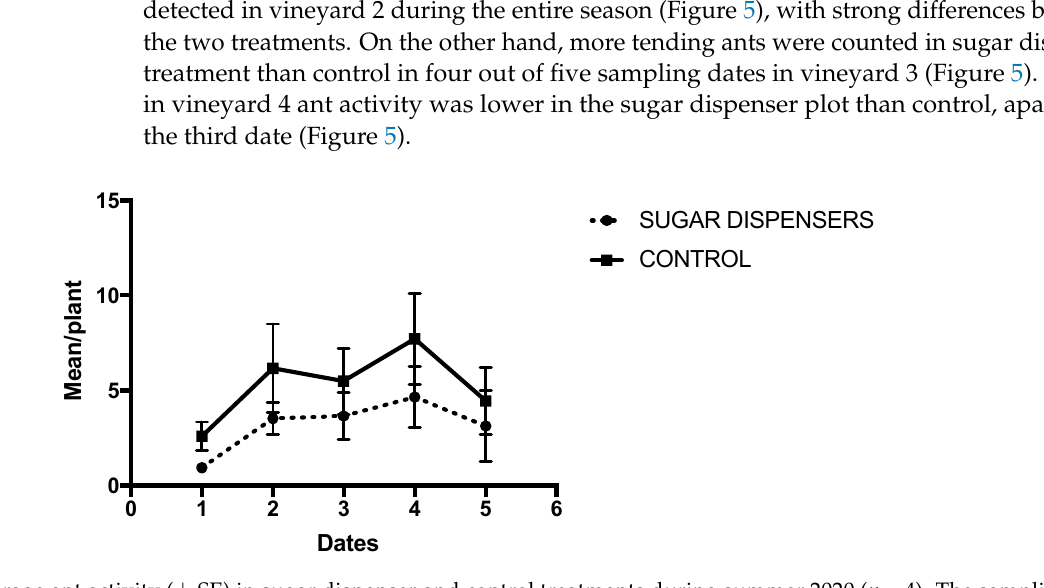
Figure 4. Average ant activity ( ± SE) in sugar dispenser and control treatments during summer 2020 ( n = 4). The sampling period started on 17th–19th of June (Date 1) and ended on 26th–28th of August (Date 5). Ant activity was estimated fortnightly. GLMM showed a significant effect of sugar dispensers on ant activity ( p = 0.034), as well as a significant effect of sampling dates ( p = 0.017). Table 2. Factor effects in the generalized linear mixed model carried out on mean number of ants counted on the vines.